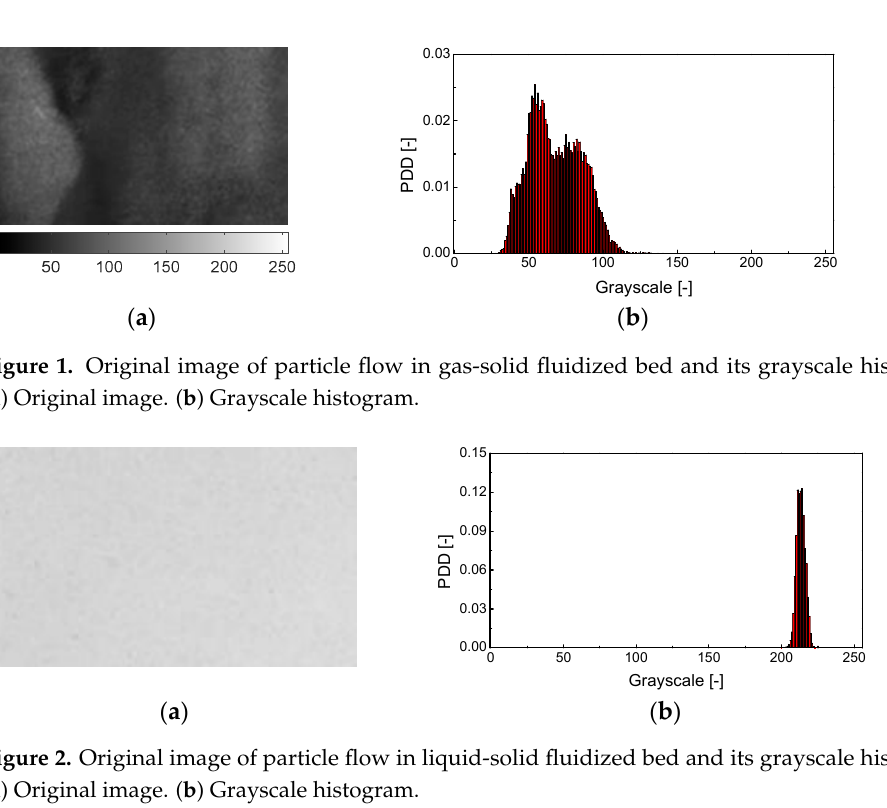
Figure 1. Original image of particle flow in gas ‐ solid fluidized bed and its grayscale histogram. ( a ) Original image. ( b ) Grayscale histogram.